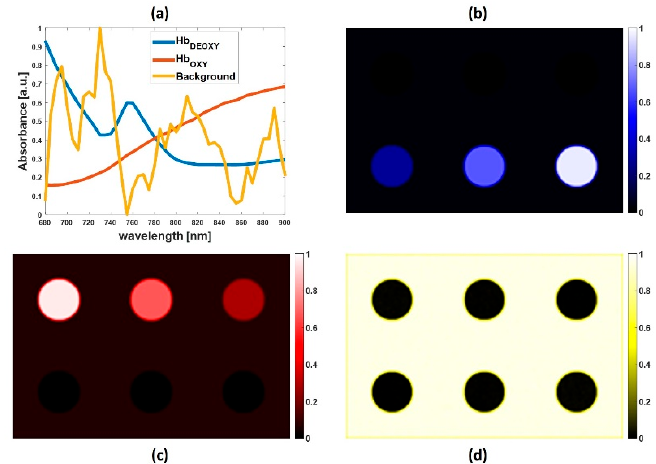
Figure 3. ( a ) Source spectra of oxyhemoglobin, deoxyhemoglobin, and background extracted by the non-negative matrix factorization (NNMF) algorithm. Abundance maps of ( b ) deoxyhemoglobin, ( c ) oxyhemoglobin, and ( d ) background.